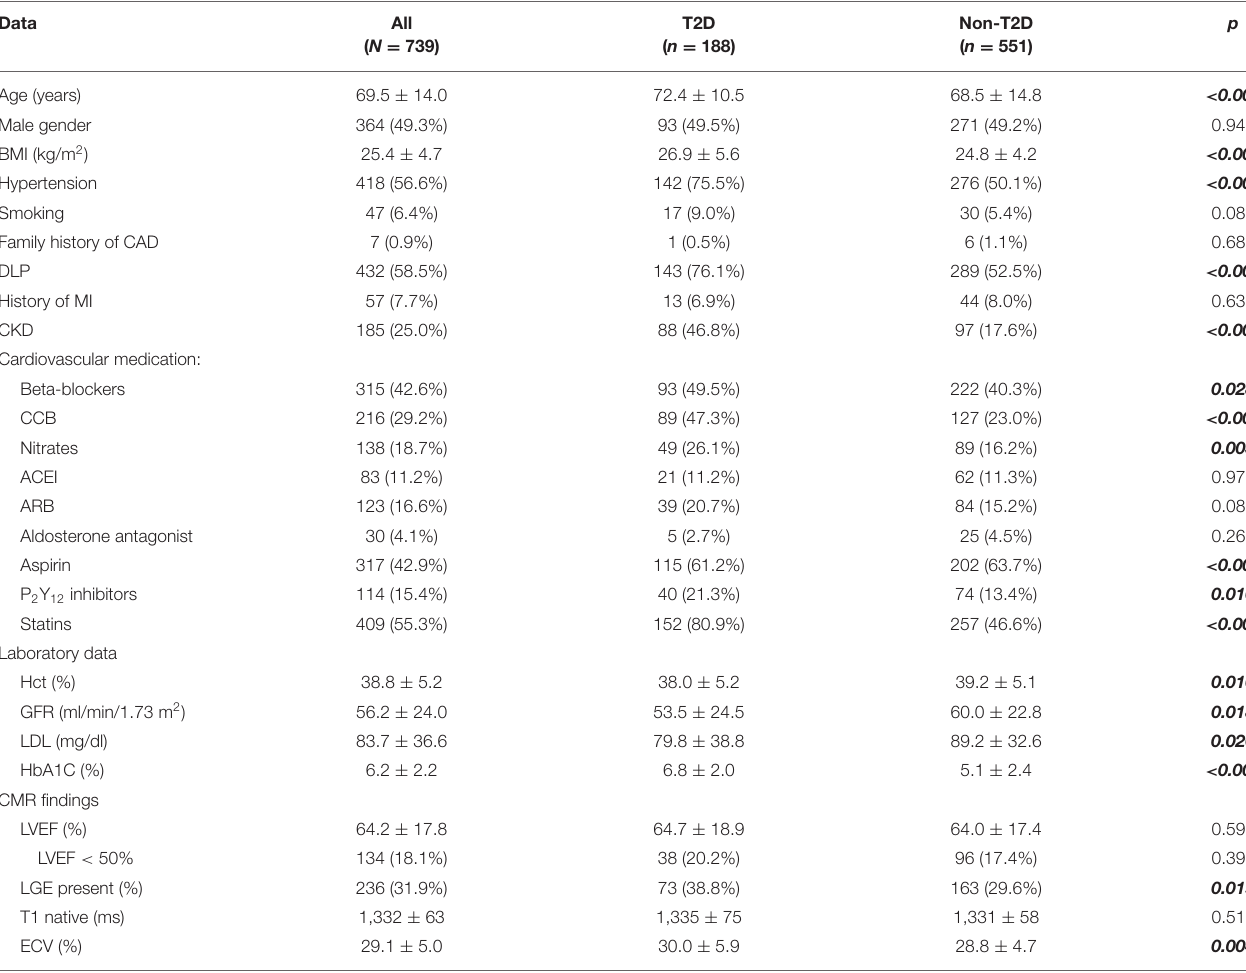
TABLE 1 | Baseline demographic and clinical data of all patients, and compared between those with and without type 2 diabetes.